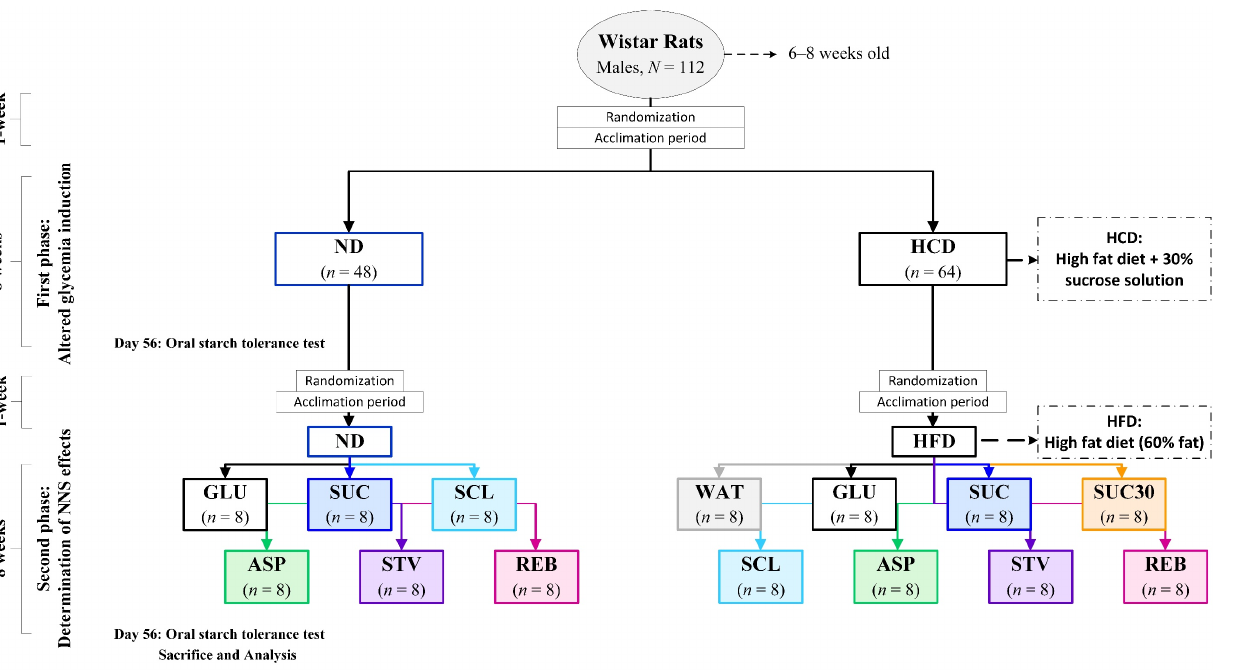
Figure 1. Schematic diagram of the experimental design.